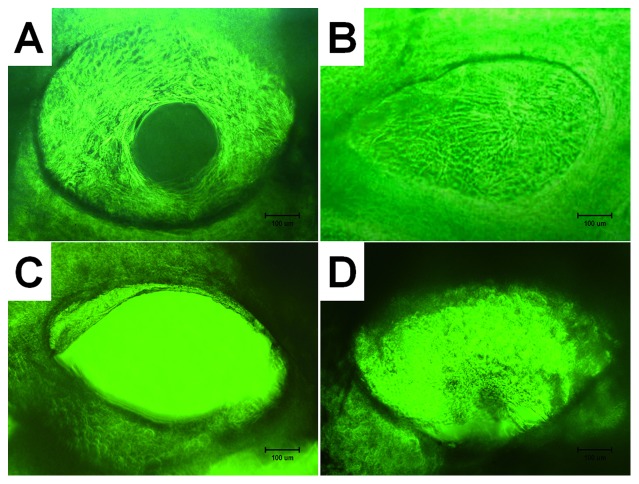
Phase-contrast photomicrographs (×100) of cell-scaffold constructs after in vitro culture for 12 d; (A) group A (dynamic seeding and dynamic culture), (B) group B (hydrogel-assisted seeding and static flask culture, (C) group C (static seeding and static flask culture, control group), and (D) group D (hydrogel-assisted seeding and dynamic culture).Bar lengths are 100 um.